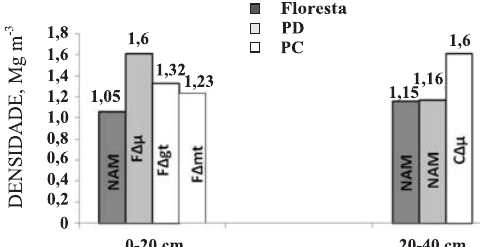
Figura 4. Densidade nos volumes estruturais homogêneos do solo sob floresta, plantio convencional e plantio direto - F ΔΔ ΔΔ Δ gt/mt/ ΔΔ ΔΔ Δ μ (com fissuras, compactado-grandes torrões/médios torrões), C ΔΔΔΔΔ μ (contínuo, em processo de compactação) e NAM (não alterado pelo